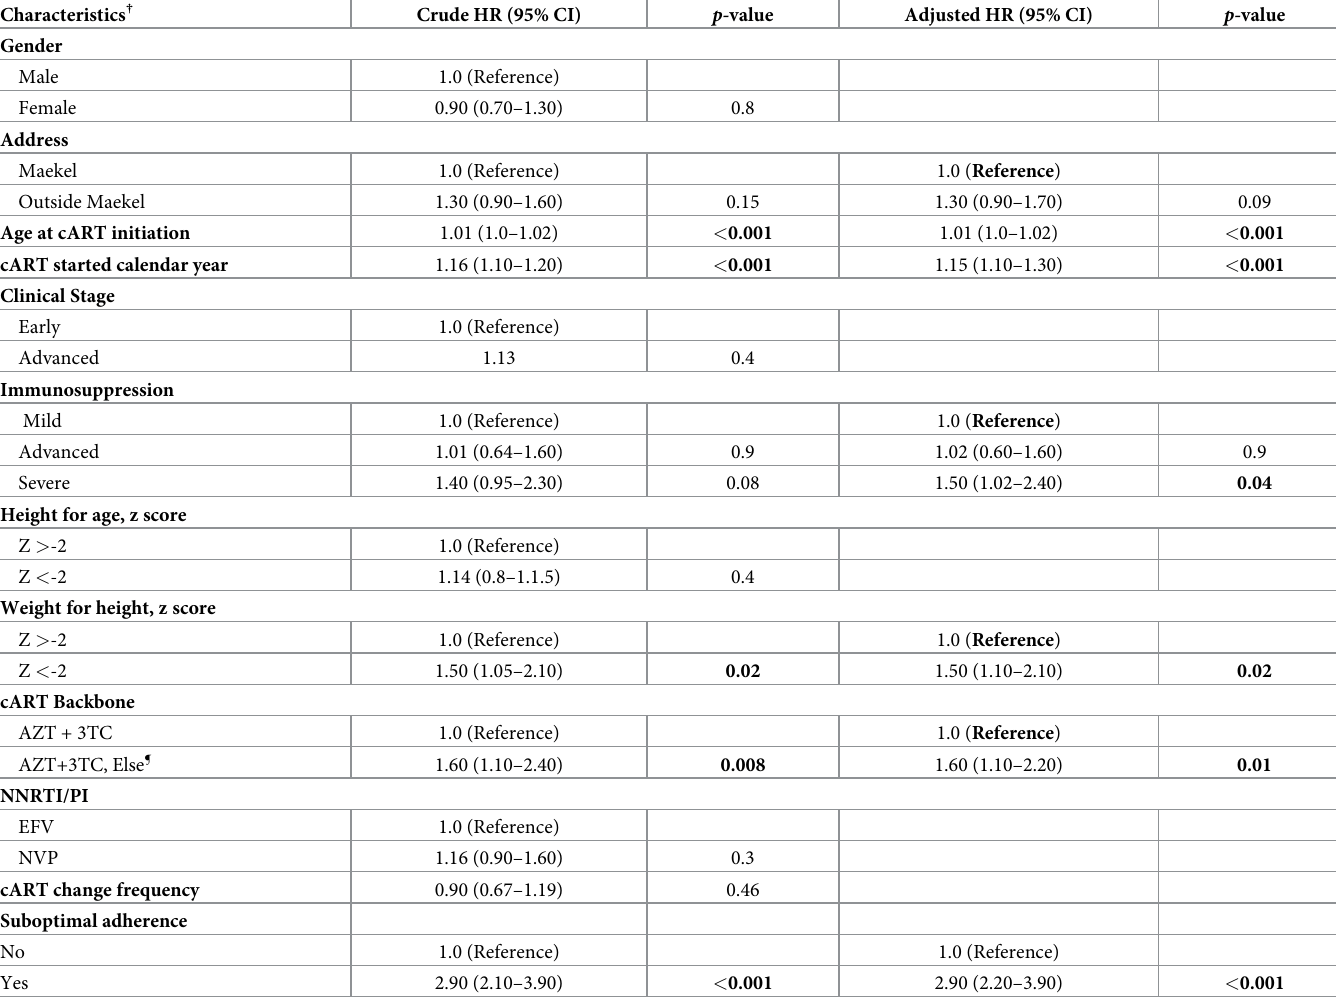
Table 4. Cox proportional hazards of cART therapy failure among CLHIV and adolescents in National Referral Pediatric Follow-up Clinic, Asmara, Eritrea (2005– 2020). Characteristics